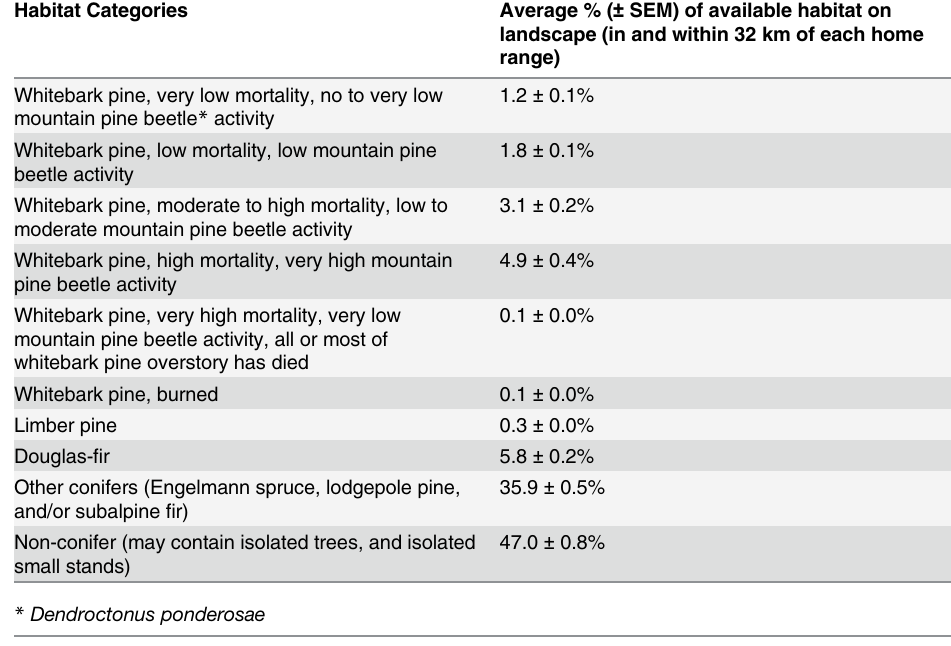
Table 1. Habitat categories. Habitat